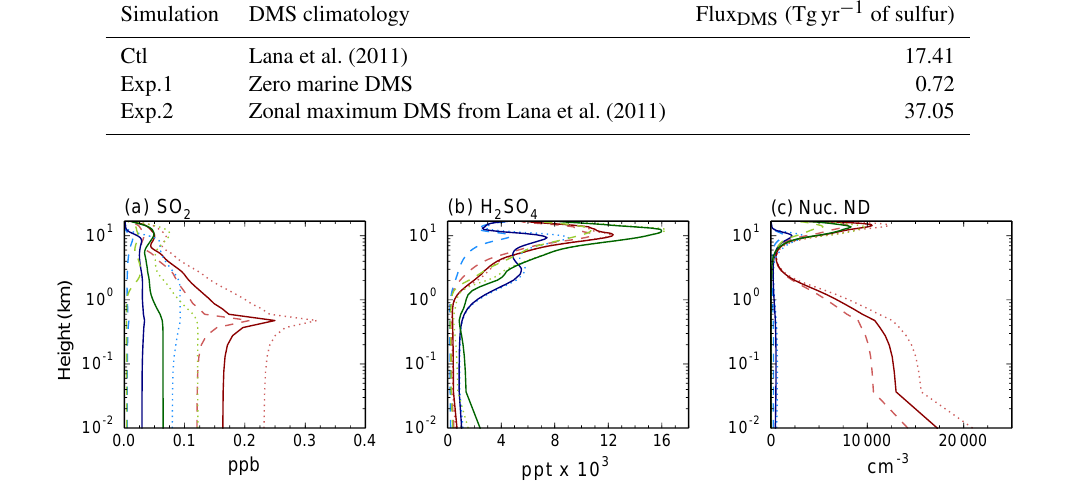
sphere, as well as some regions of the SO. In heavily pol- luted terrestrial regions a small increase in the N 3 number concentration occurs. A decrease of 8 % is found globally. For the Australian region (representative of a clean, terres- trial region), a decrease of 17 % is